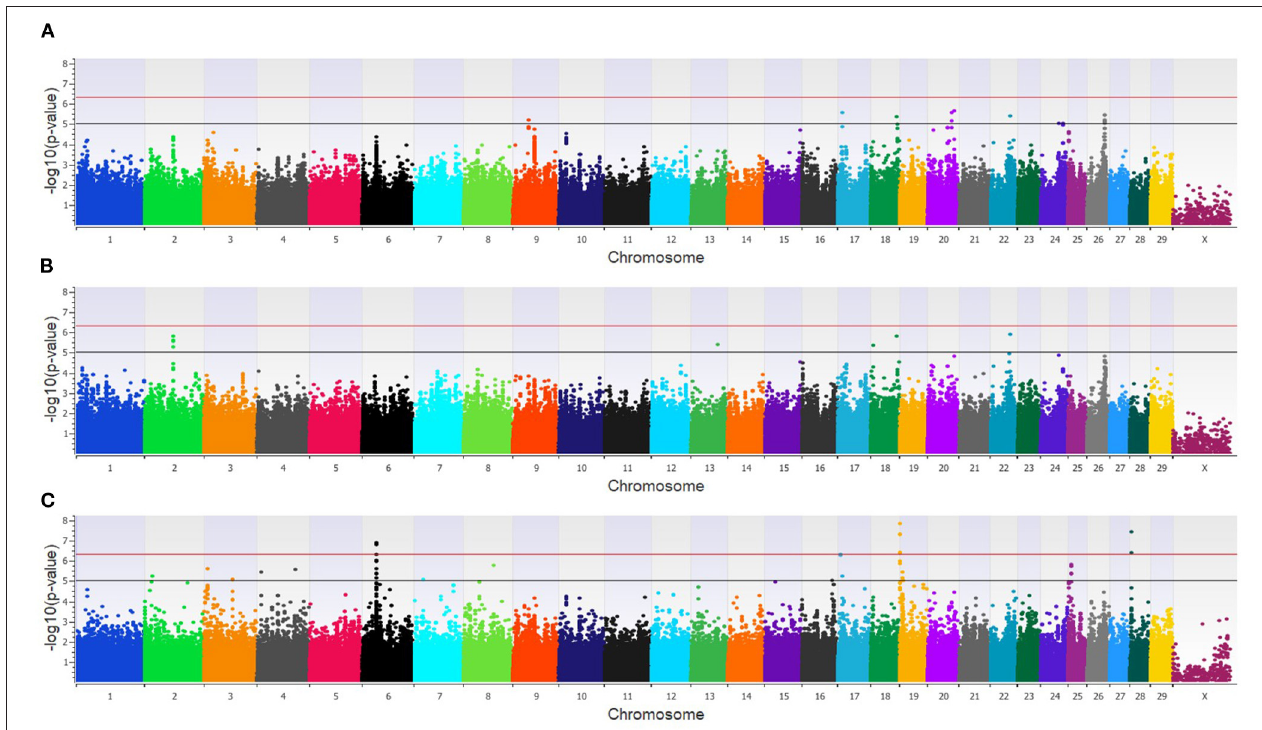
FIGURE 6 | Manhattan plots identifying loci associated with bovine coronavirus infection and bovine respiratory disease in additive (A) , dominant (B) , and recessive (C) EMMAX models for the combined dairy and feedlot population. Single-nucleotide polymorphisms (SNP) are represented by a single dot. Bovine chromosomes are listed on the x-axis. SNPs located between the black and red lines provide evidence of a moderate association ( p between 1 × 10 − 5 and 5 × 10 − 7 ), and SNPs above the red line provide evidence of a strong association ( p < 5 × 10 − 7 ) based on the Wellcome Trust Case Control Consortium ( 24)